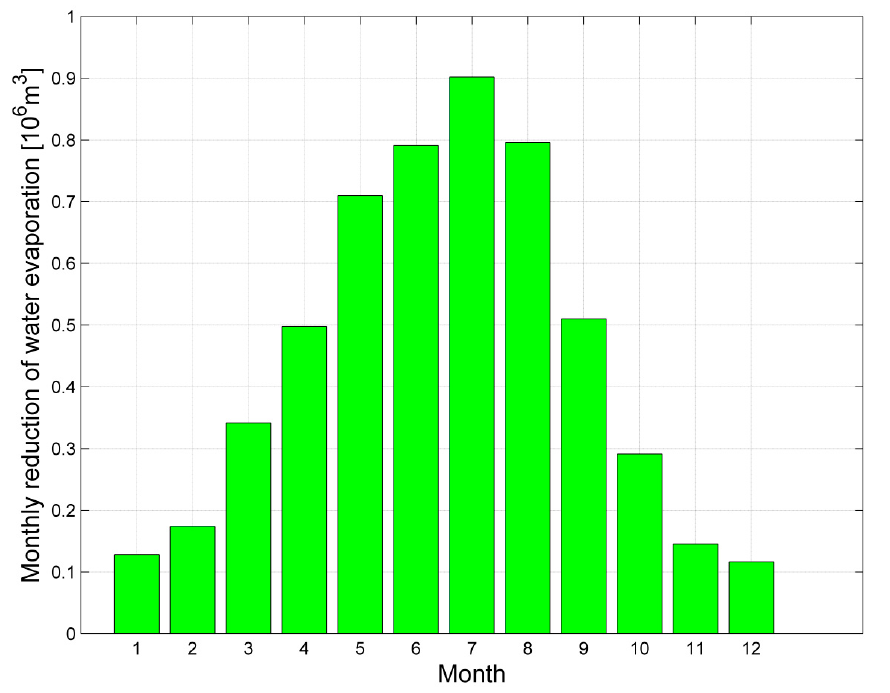
Figure 15. Monthly reduction of water evaporation at Skadar Lake after building the FPPP.